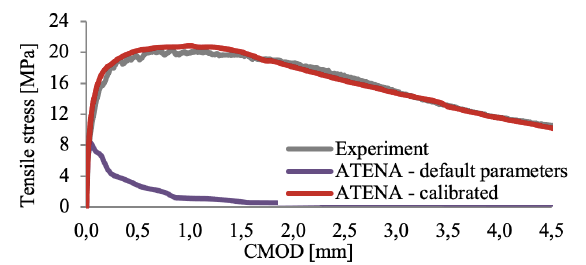
Figure 4. The experimental loading curves of the tested non-strengthened panels compared with the calibrated ATENA simulation.